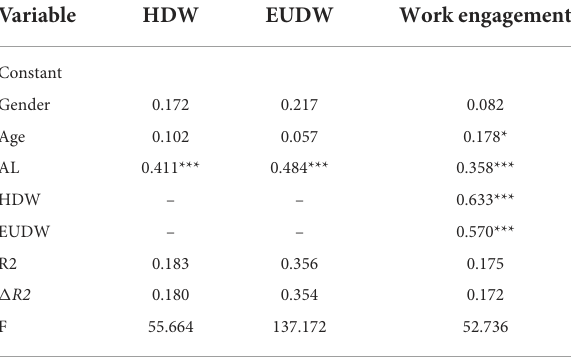
TABLE 3 Regression analysis of authentic leadership, hedonic wellbeing, eudaimonic wellbeing, and work engagement. Variable